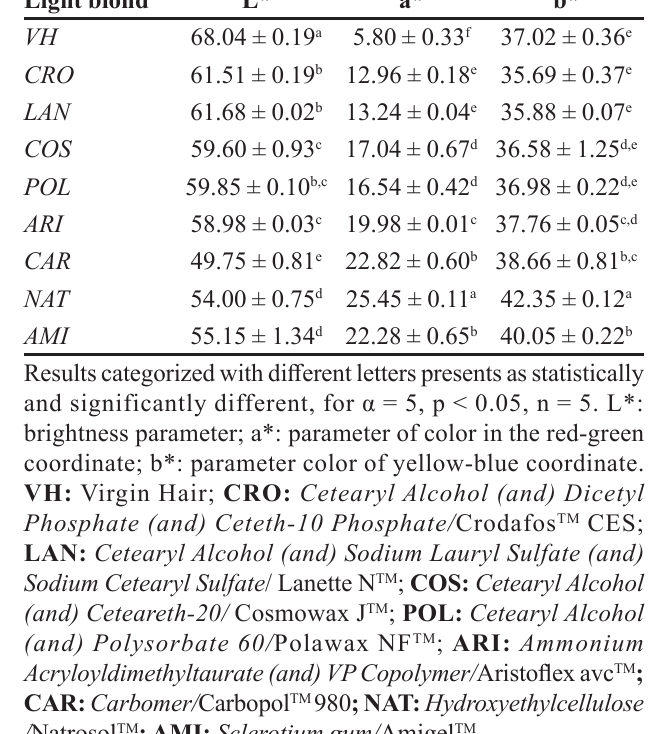
TABLE V - Color and Brightness parameter for Caucasian light blond virgin hair and samples treated with light brown oxidative hair dyes Treatment hair dye color